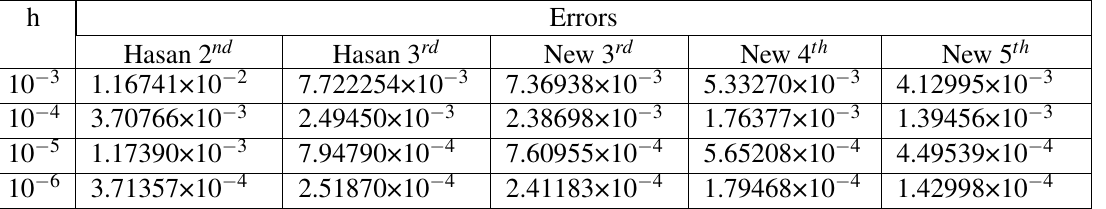
Table 4.1 (b): Absolute errors of rhe solution of Eq. (21) at x = 0 . 0001 by Hasan’s [13, 16] methods and new methods. h